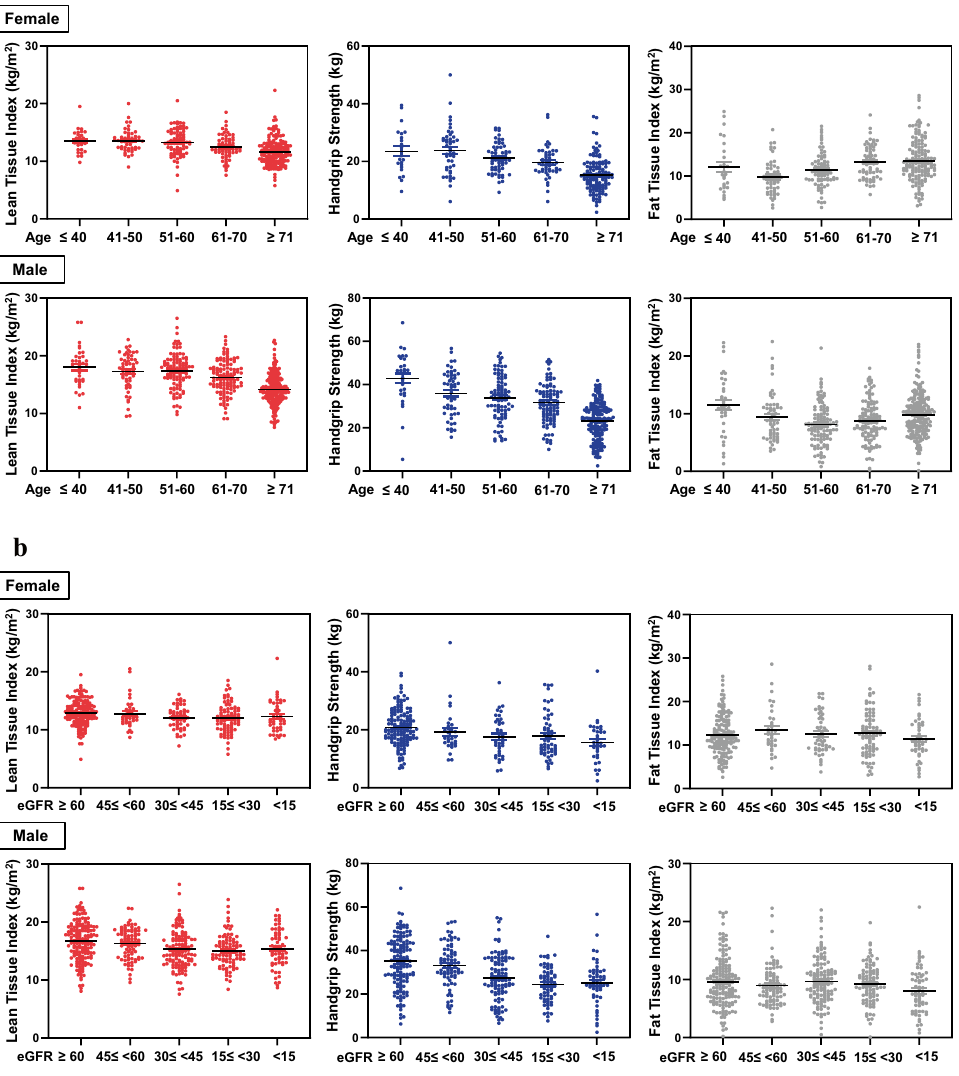
Figure 2. ( a ) Change in body composition and handgrip strength according to age. LTI and HGS decreased significantly with age, and FTI showed a U shape (top, female; bottom, male). ( b ) Change in body composition and handgrip strength according to the estimated glomerular filtration rate (eGFR). The change according to the eGFR did not show a significant difference in the fat tissue; however, the LTI tended to decrease somewhat as the renal function decreased. Above all, the HGS showed a significant decrease in the higher stage of chronic kidney disease (top, female; bottom,